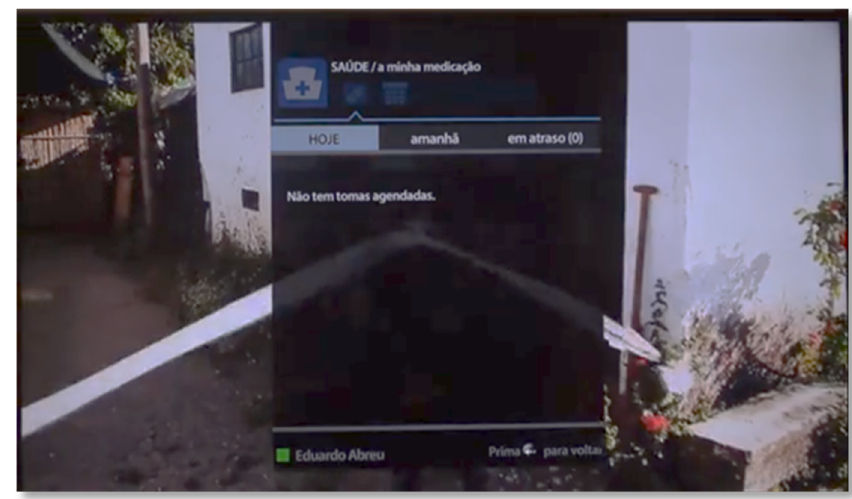
Figure 5. Medication scheduled for today in SecurHome TV application.